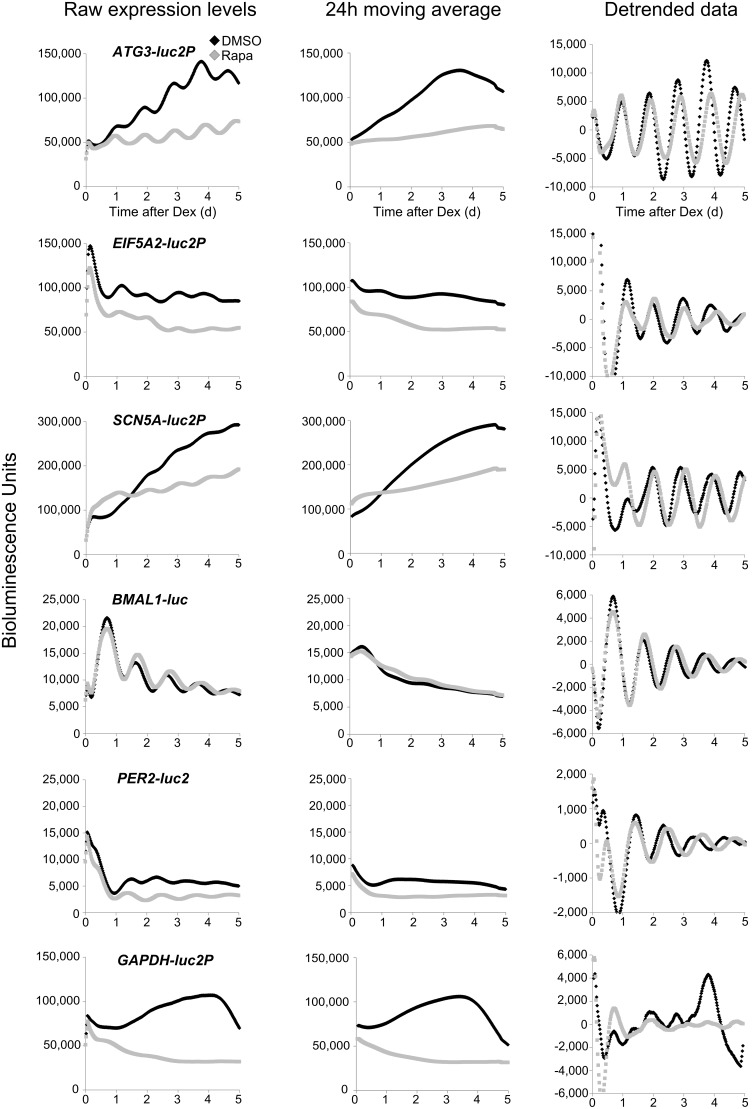
Rhythmic transcription of genes with CRBSs in their promoter is masked by high baseline expression.Robust low amplitude transcription rhythms revealed by long-term luminescence measurements of stable U2OS cell lines expressing the destabilized luciferase2P (luc2P) under control of the promoters of ATG3, EIF5A2, and SCN5A. BMAL1-luc, PER2-luc2, and GAPDH-luc2P cell lines are shown for control. Luminescence of synchronized cultures was measured at 30 min intervals. Raw expression data of the indicated reporter genes for day 1 to day 5 after synchronization are shown in the left panels. The middle panels show the 24 h moving average of the luciferase activity to estimate the non-rhythmic contribution and the right panels show the de-trended data to estimate the rhythmic contribution. The black and grey traces show expression profiles in the absence and presence of 200 nM rapamycin, respectively.